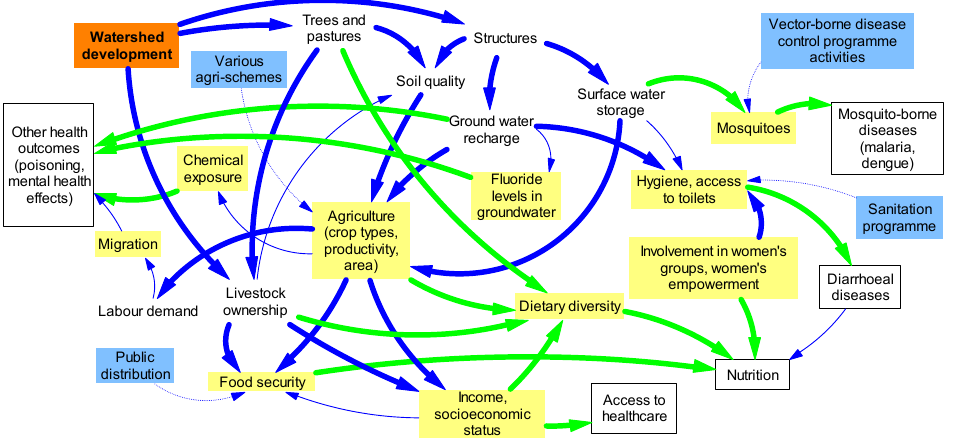
Figure 2. Potential pathways to health impacts of WSD projects (thick blue arrows indicate project activities; blue boxes and dotted arrows indicate governmental programmes; yellow boxes indicate health-determining impacts; thick green arrows indicate potential health impact pathways; white boxes indicate potential health impacts of WSD projects).